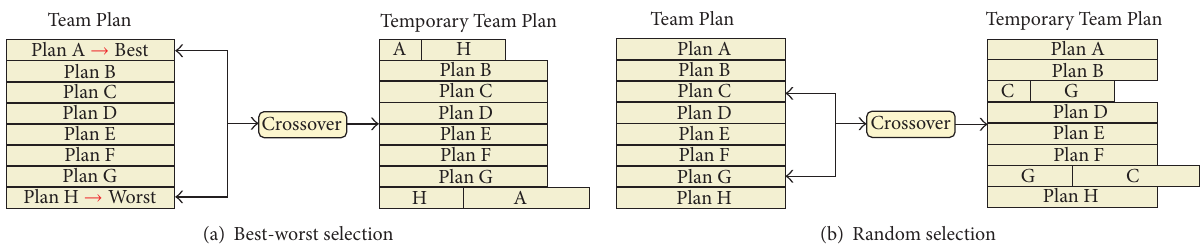
Figure 2: Crossover operator. (a) In case of best-worst selection the best and the worst subtours are mated (with probability 𝑝 By random selection the two subtours are selected at random (with probability 1 − 𝑝